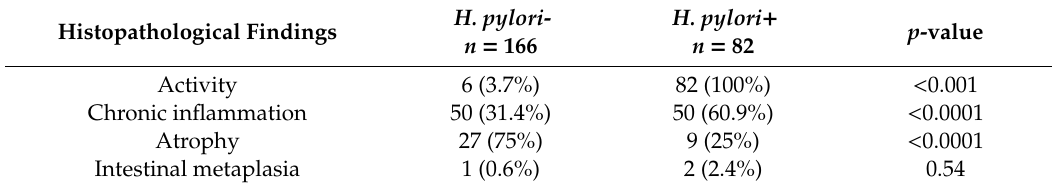
Table 5. Histopathological findings in the gastric mucosa in children with and without H. pylori infection.